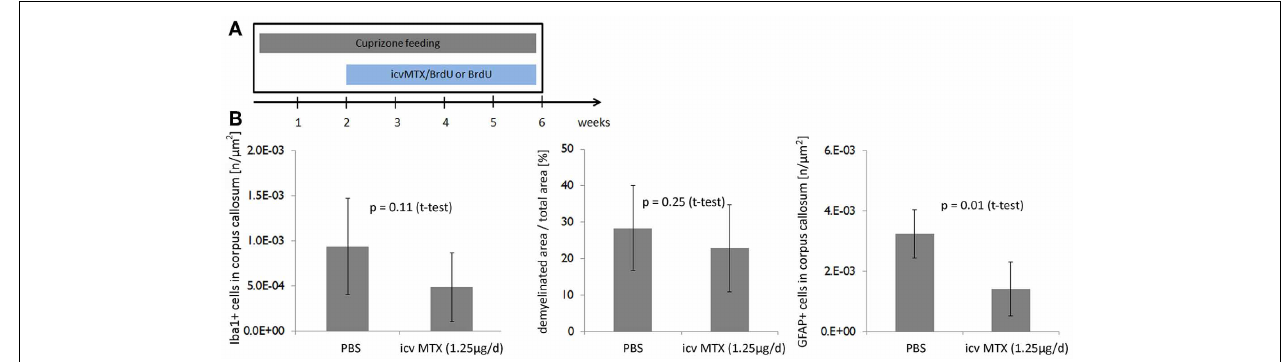
BrdU/PBS intracerebroventricularly or just 10mg/mL BrdU in PBS. (B) Quantitative analyses of demyelination and numbers of macrophages/